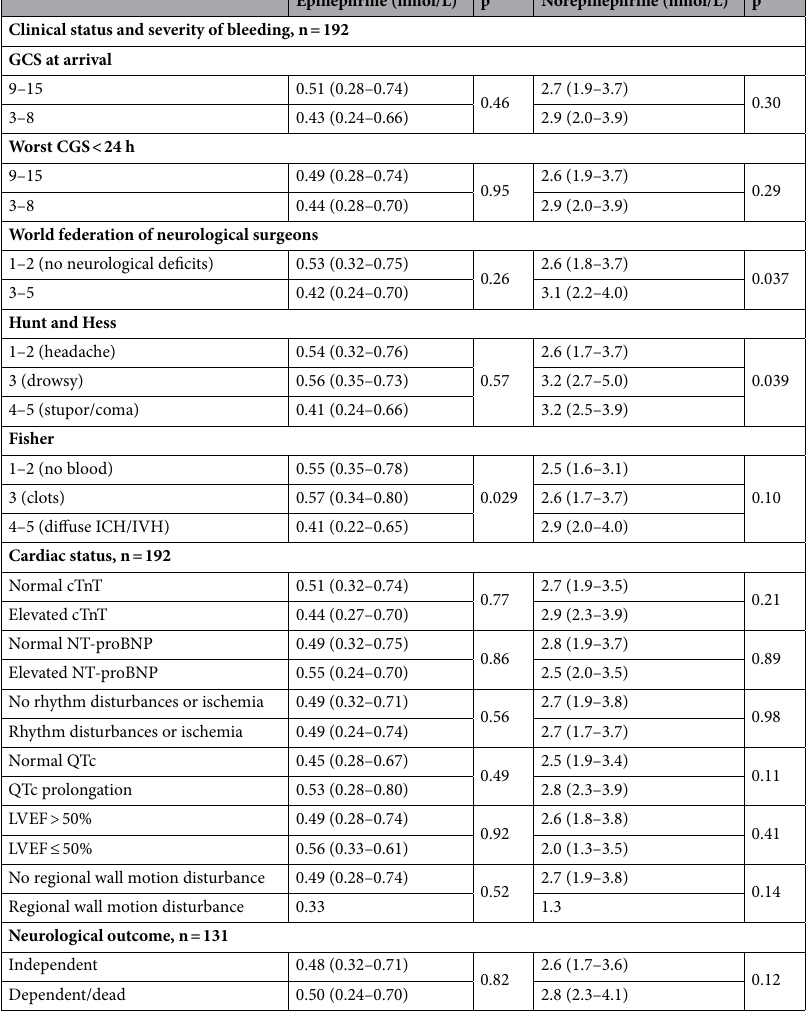
Table 7. Endogenous catecholamine concentrations at day 1 according to clinical and cardiac status, and neurological outcome at day 90. Patients with norepinephrine infusion (n = 65) were excluded from the analyses. cTnT cardiac troponin T, GCS Glasgow coma scale, LVEF left ventricular ejection fraction, NT-proBNP N ‐ terminal pro ‐ B ‐ type natriuretic peptide, QTc corrected QT